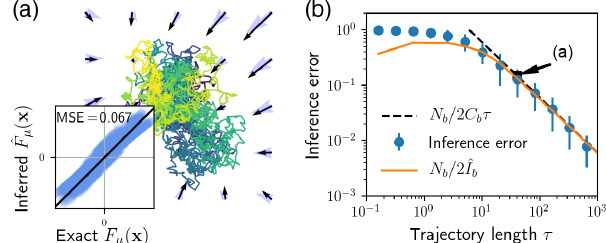
FIG. 3. Stochastic force inference for a 2D Ornstein-Uhlenbeck process with force field F μ ð x Þ ¼ − Ω μν x ν and isotropic diffusion. (a)An example trajectory. Theinferredforcefieldforthistrajectory using SFI with functions b ¼ f 1 ; x μ g (blue arrows) is compared to the exact force field (black arrows). Inset: The inferred force components along the trajectory versus the exact force components with normalized mean-squared error (MSE). (b) The average of the ˆ F ˆ F ˆ F ˆ F − 1 − 1 − F τ − F τ relative error ½ð μα να μα D να (cid:2) on the μα Þ D μν ð να Þ(cid:2) = ½ μν ˆ F inferred projection coefficients μα and its self-consistent estimate N = 2 ˆ I = 2 I both converge to N , as expected from theory (see R b b b b F μ ( x ð t Þ ) ˆ c α ( x ð t Þ ) ð dt= τ Þ is the pro- Appendix C). Here, F τ μα ¼ jection of the exact force on the empirical